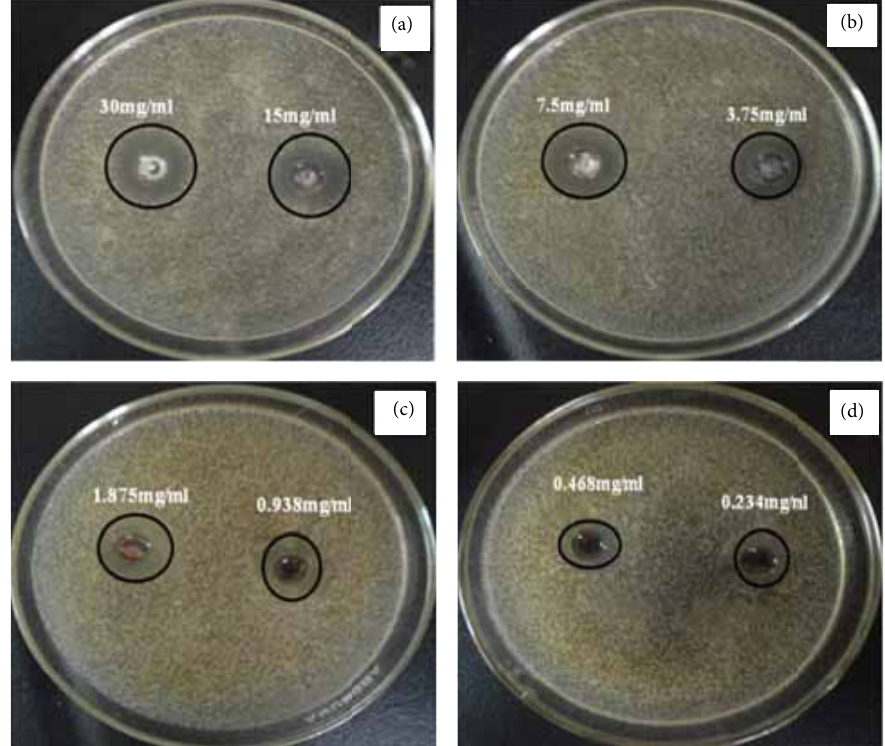
Figure 19: The antimicrobial activity of zinc oxide nanotubes against Staphylococcus aureus using disc diffusion method. ((a), (b), (c), and (d)) Different concentrations of the synthesized ZnO.